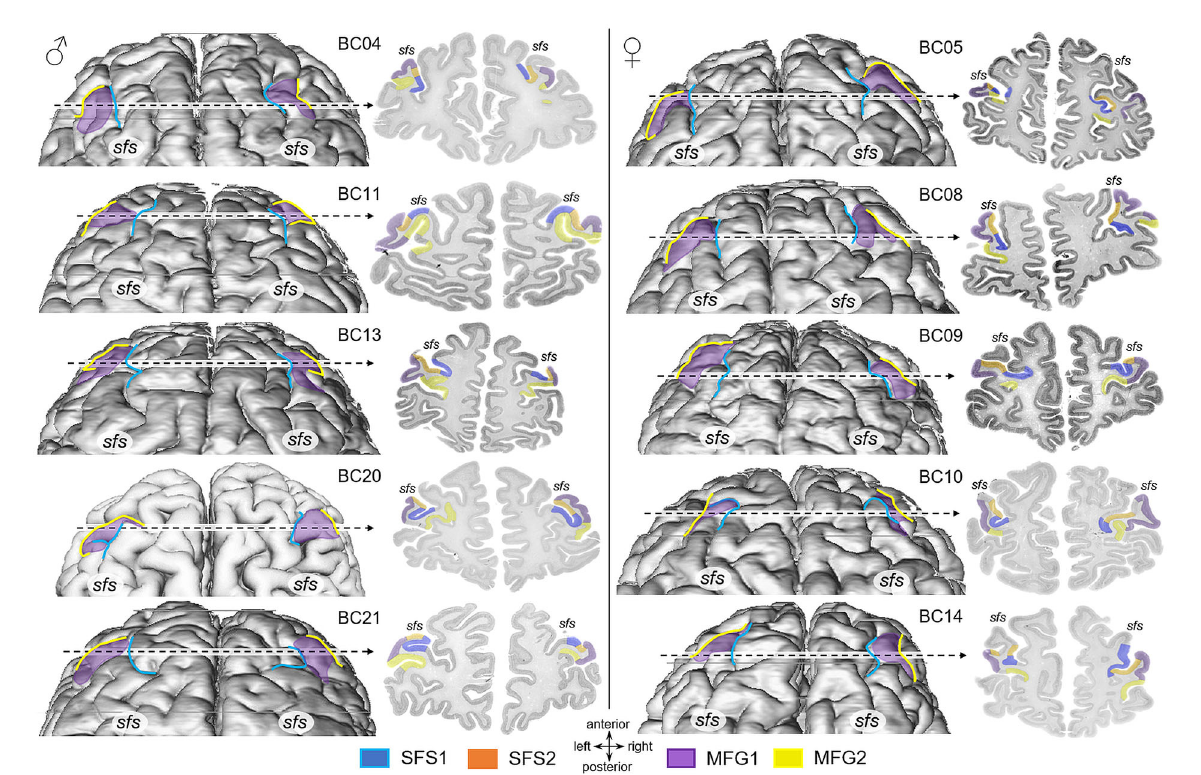
FIGURE4 Dorsal views of 3D area reconstructions of ten individual brains. Dorsal surface reconstruction of areas SFS1 (blue), MFG1 (purple), and MFG2 (yellow) separated by sex (male brains: left, female brains: right) showing the interindividual variability concerning differences in size and shape of areas and variability in the sulcal pattern. Area SFS2 was excluded from the reconstruction for visualization reasons. The dotted line indicates the localization and extent of cytoarchitectonic areas SFS1, SFS2, MFG1, and MFG2 on the corresponding histological section. Area SFS1 was predominately situated in the superior frontal sulcus ( sfs ) depth. Area SFS2 joined SFS1 in the sulcus and reached the surface of the anterior part of the middle frontal gyrus, occupied by the area MFG1. Adjacent to area MFG1, area MFG2 reached into the ventrally neighboring